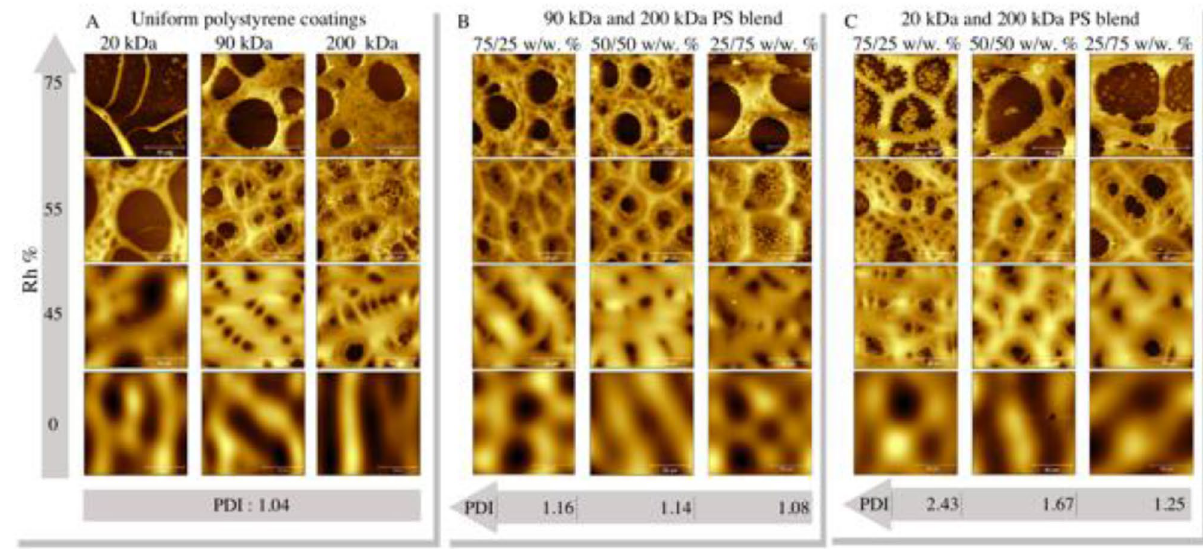
Figure 11. AFM topographical images of tested samples. The colour represents the height, and brighter means higher. The solution concentration C was 80 mg/ml, while the samples were spun under different humidity, from 0 to 75% Rh. The z-scale was chosen for the best representation of the coating morphology. ( A ) uniform coatings; ( B ) 20 kDa and 200 kDa blends; ( C ) 91 kDa and 200 kDa blends.